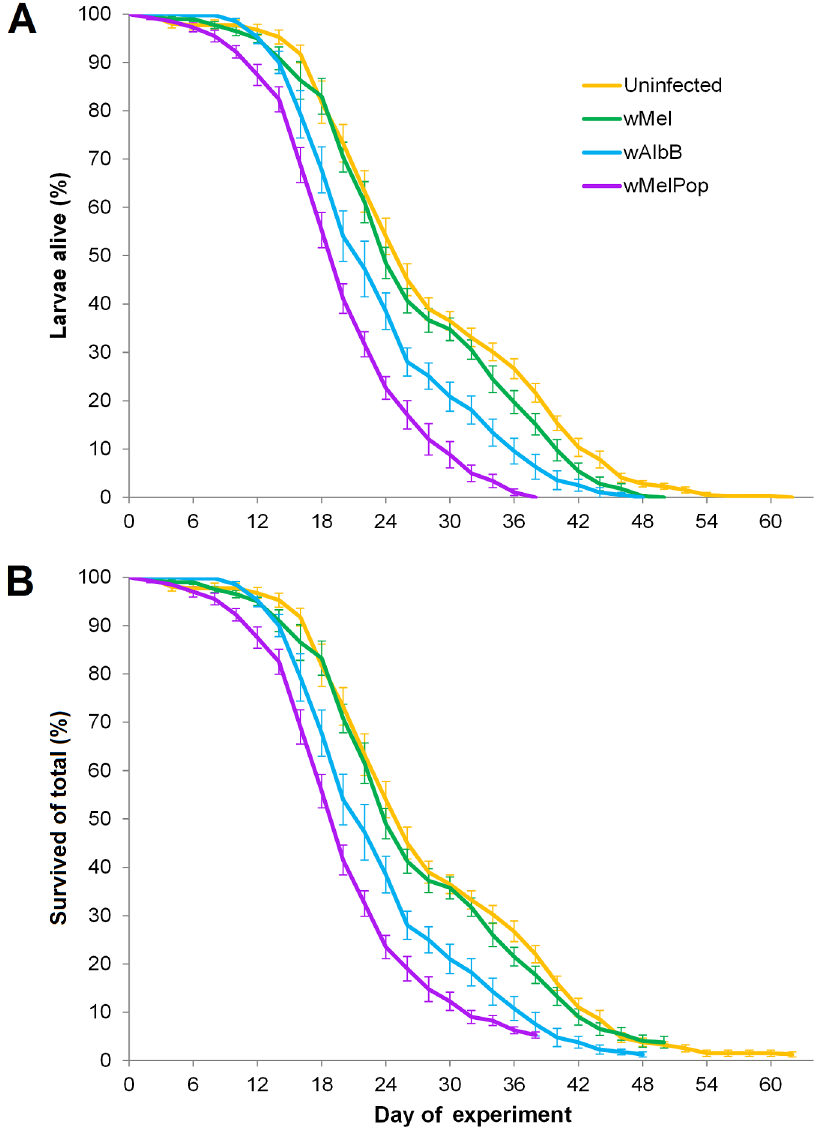
Fig 2. Survival of Ae . aegypti larvae under starvation conditions in groups of 50 per container. (A) Shows only larval mortality for each line and excludes those larvae that emerged as adults, while (B) is adjusted so that emerging adults are included in the survivors. Error bars are standard